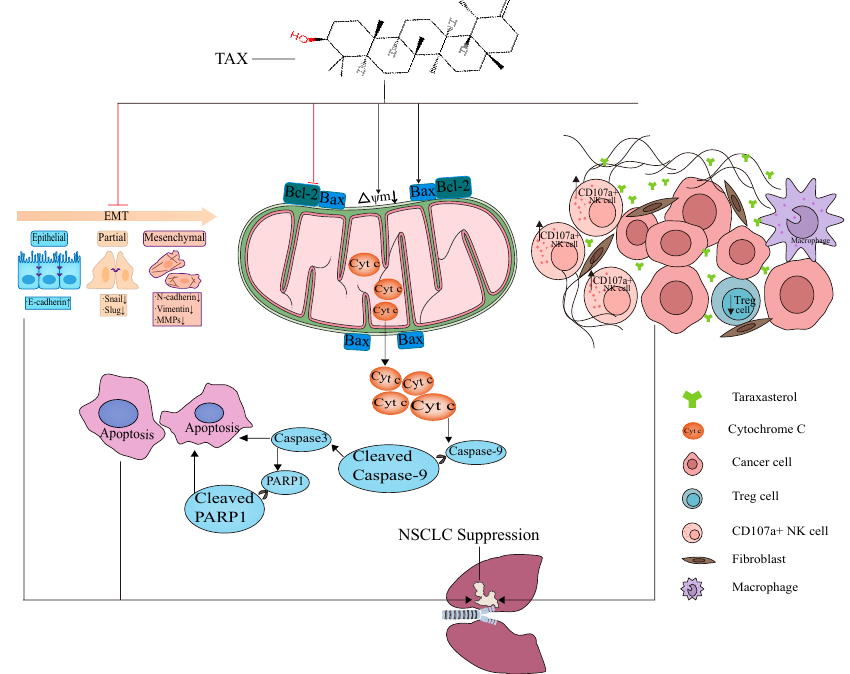
Figure 11. Schematic depiction of the anti-NSCLC effects of TAX.